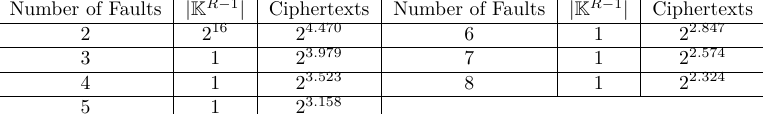
Table 6: The required number of faulty ciphertexts of